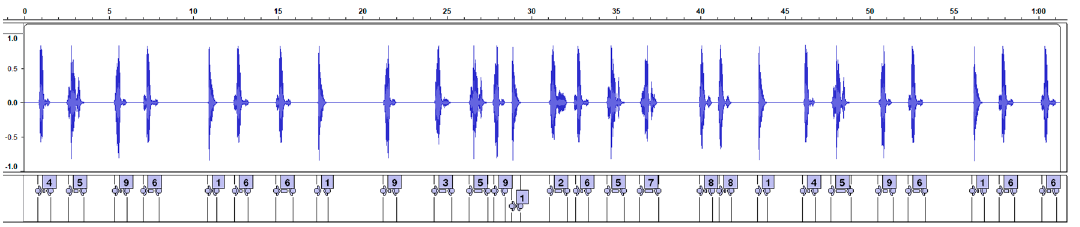
Figure 3. Screenshot of Audacity. The audio track is shown (top) together with the digits (bottom). This audio track was used for all dual-task trials. The duration of the track is sixty